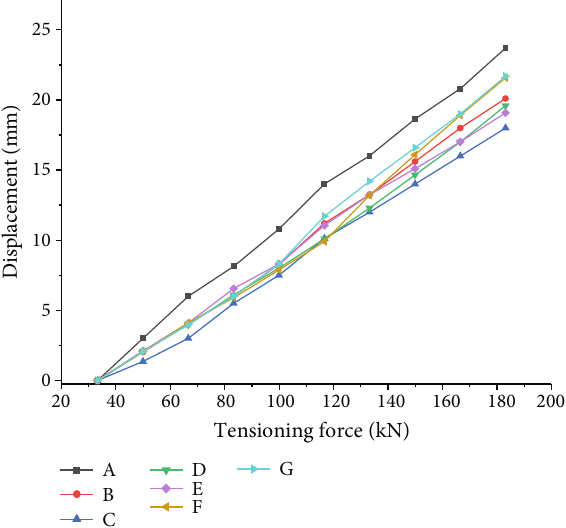
Figure 7: The relationship between the elongation and the tensioning force in the stage of single bunch